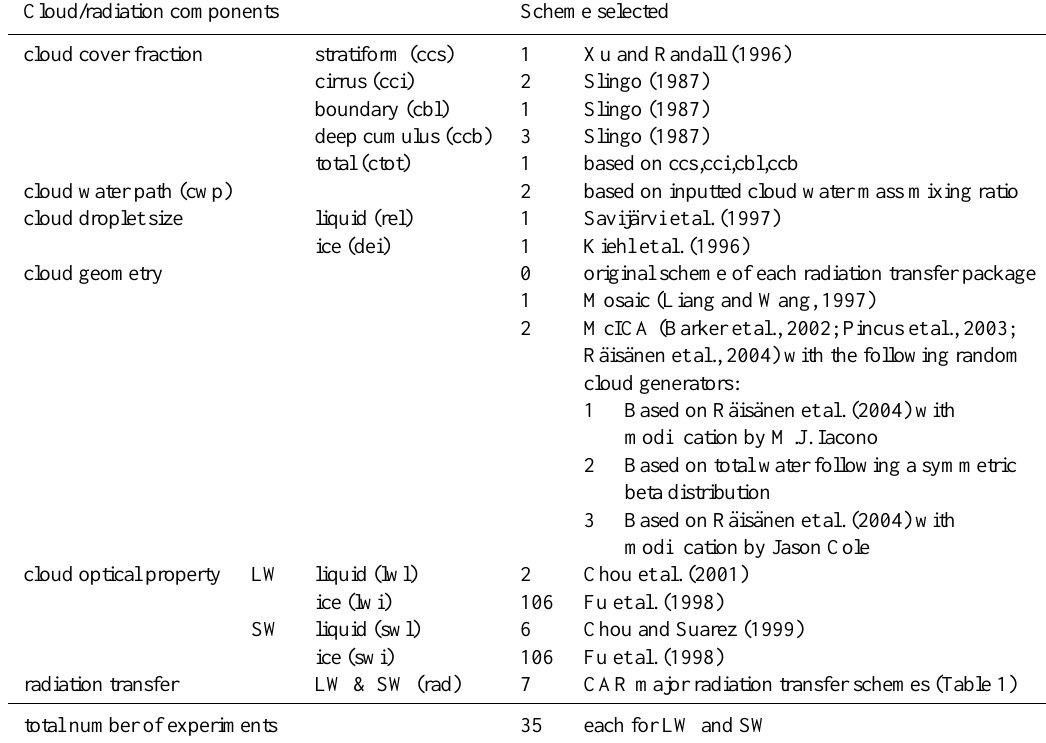
Table 3. The experiment design for cloud vertical overlap effect.